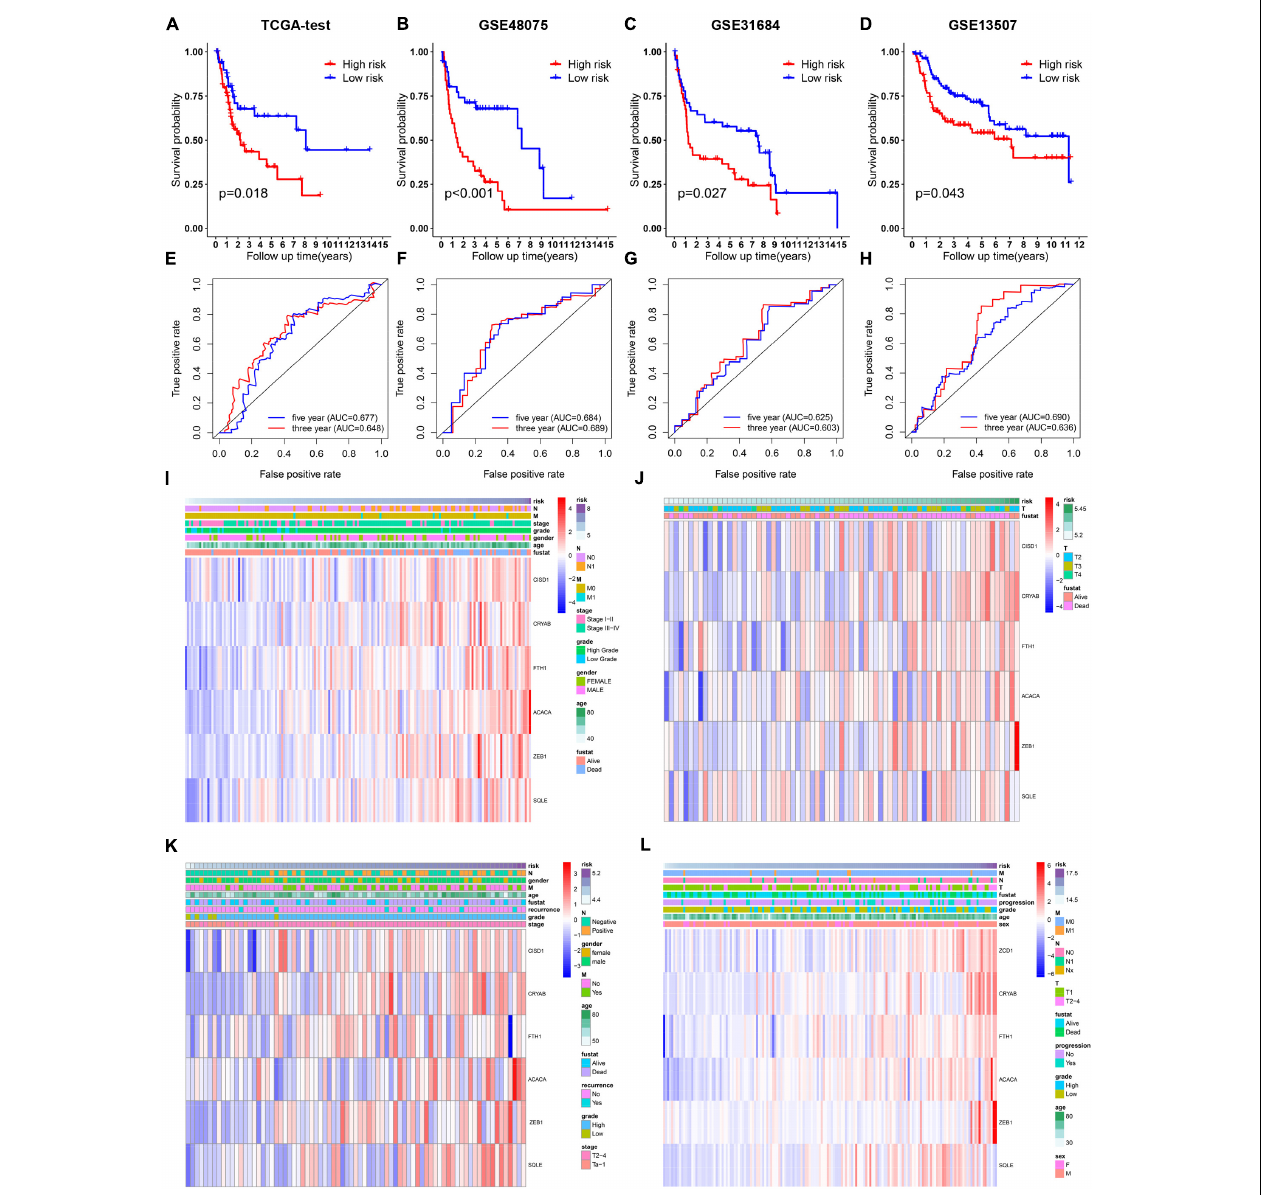
FIGURE 3 | Validation of the 6-gene signature model in the internal TCGA and another indicated three independent public datasets. (A–D) Kaplan-Meier survival curves for bladder cancer patients based on risk score in TCGA, GSE48075, and GSE31684, and GSE13507 datasets. (E–H) ROC curve analysis for predicting 3- and 5-year overall survival in the above four BC cohorts. (I–L) Heatmaps showing the expression level of 6 selected ferroptosis-related genes ranked by risk score in the above four BC